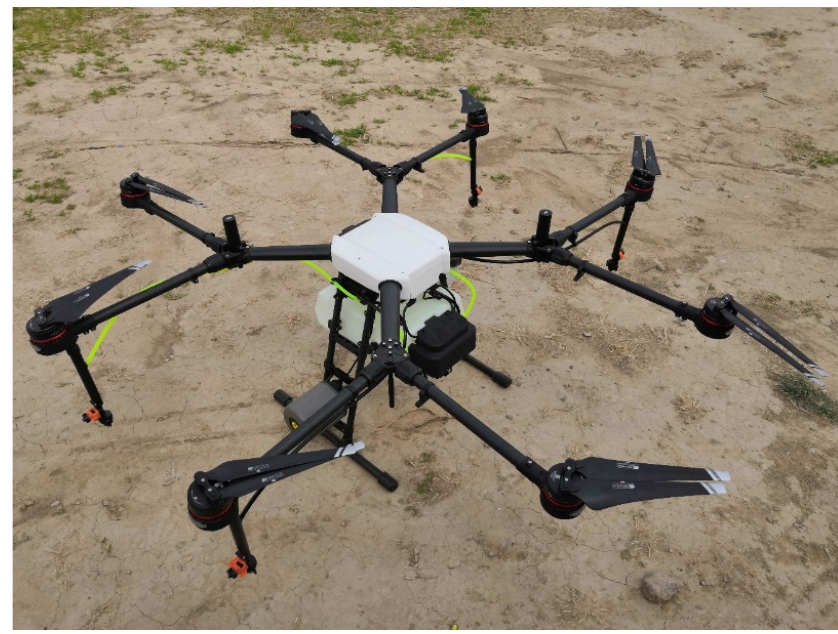
Figure 1. DJI AGRAS MG-1P UASS applied in spray drift tests.